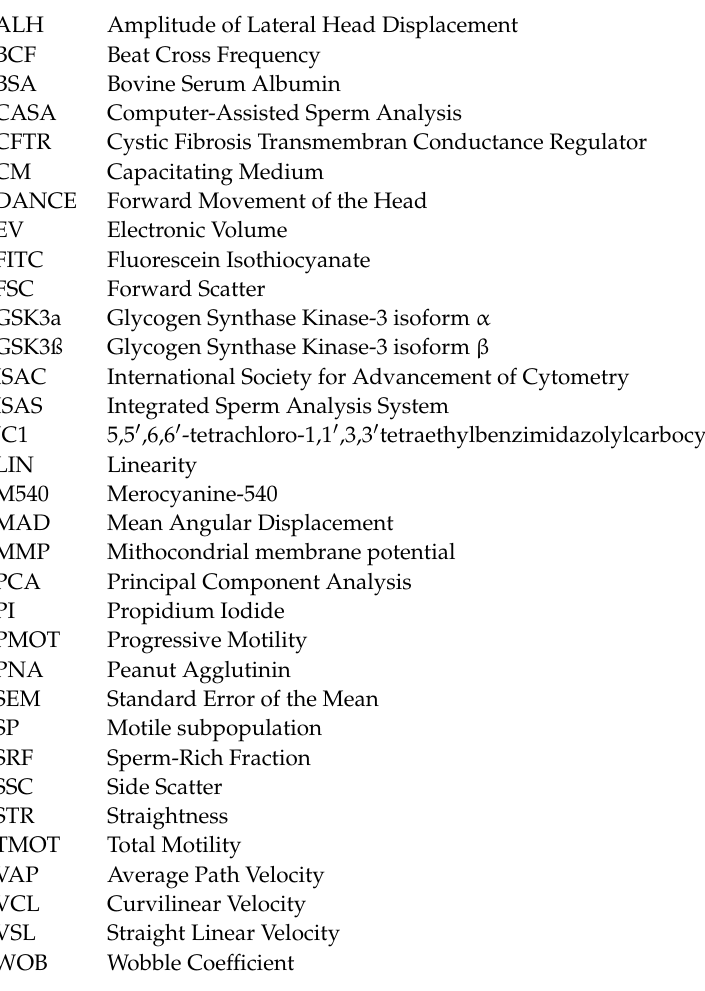
blocked samples; Figure S3: Representative dot-plots for JC1 staining in control and quinine- and PAX-blocked